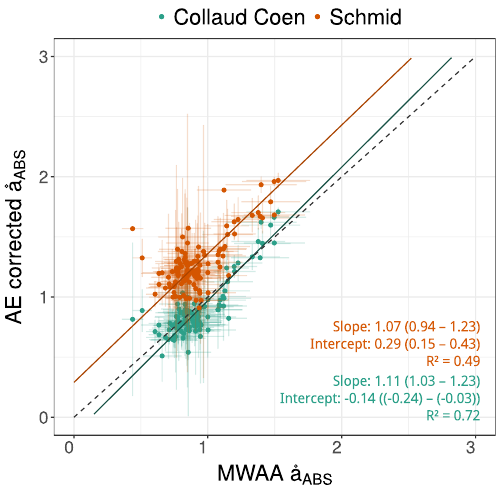
Figure 8. Overestimation of Aethalometer corrected absorption co- efficients relative to MWAA at 370nm. Values above zero are re- lated to an overestimation of σ ap and, below zero, to an underesti- mation of σ ap at this given